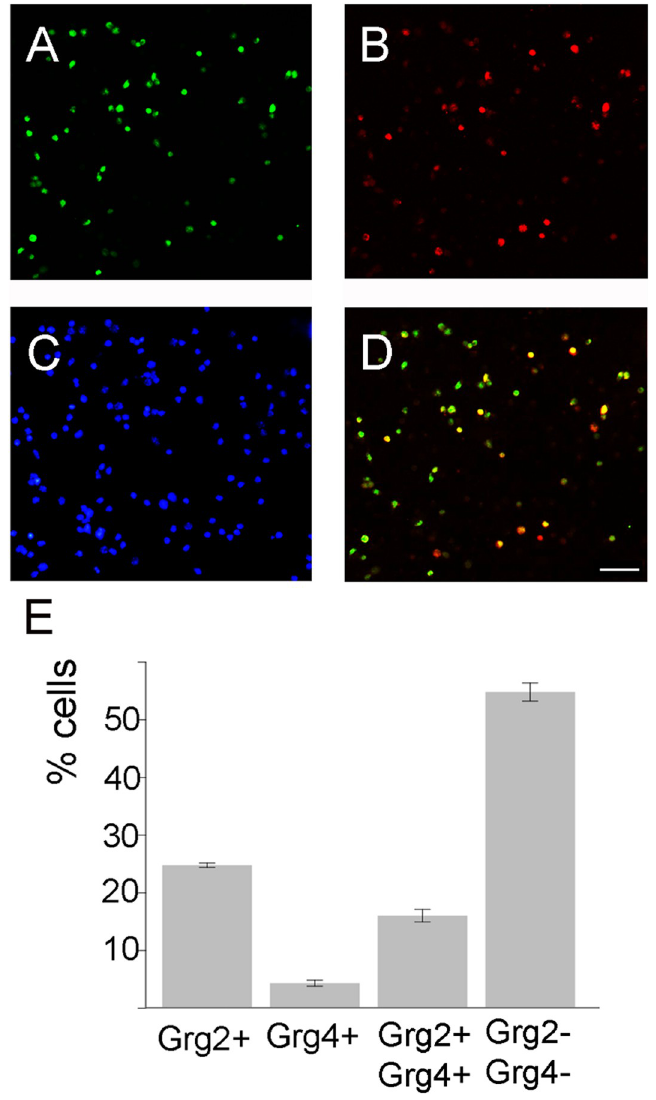
Fig 10. immunofluorescence on primary MGE cells from E13.5 embryonic brain cultured with an anti-Grg2 antibody (A, D green) and an anti-Grg4 antibody (B, D red). The nuclei were detected with DAPI (C,D). (E) Graph showing the percentage of Grg2+, Grg4+, Grg2+/GRG4+ and Grg2-/Grg2- cells of the MGE. Values represent the mean ± SEM of the immunoreactive cell number, expressed as the percentage of total cell counts from 3 independent experiments. Statistical analyses were performed using Student’s t-test. � P < 0.05. Scale: 50 μ m.